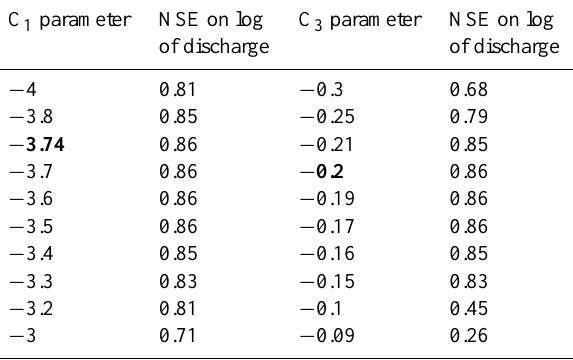
Table 9. NSE values of log discharge for the Ardèche at Meyras (#1) catchment, illustrating sensitivity to changes in the C 1 and C 3 parameters. In bold: values obtained from